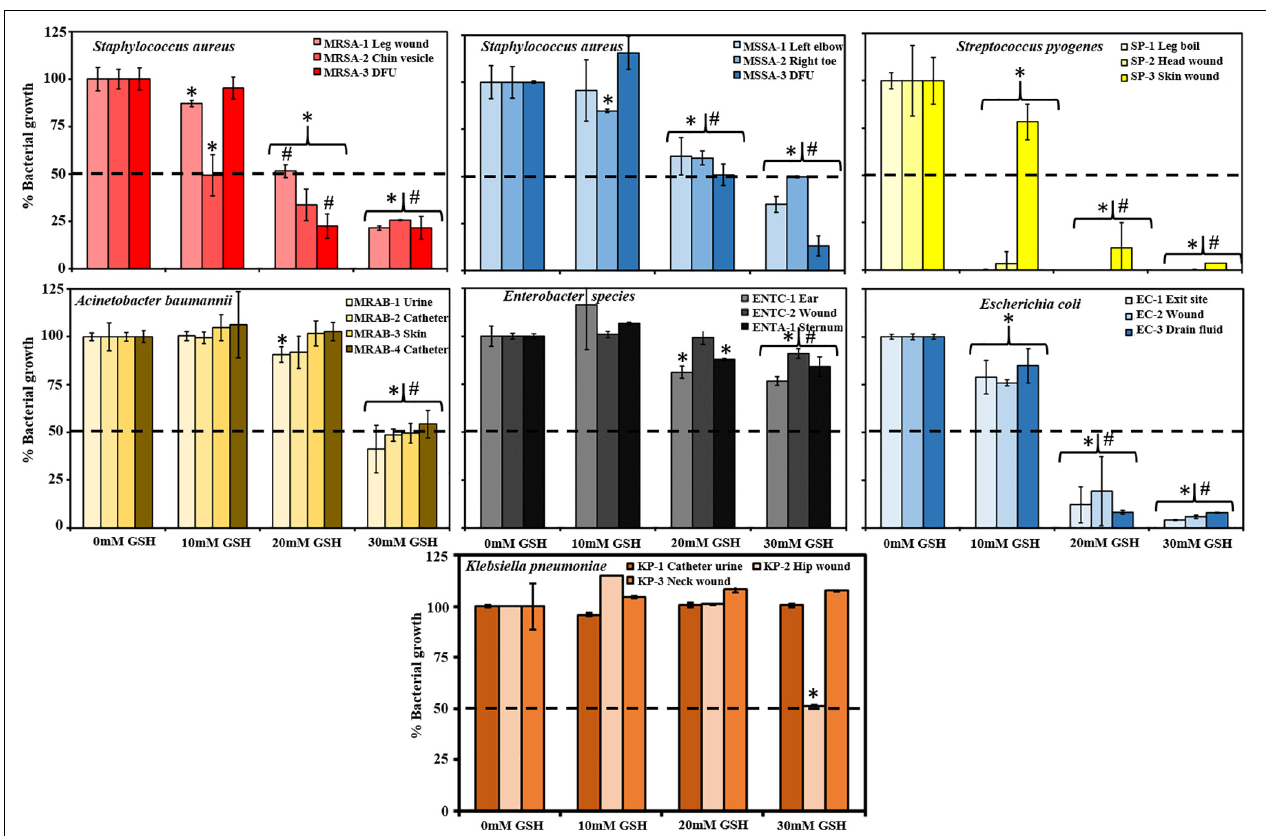
FIGURE 1 | Effect of Glutathione (GSH) on growth of bacterial species isolated from Sydney hospitals. GSH showed concentration-dependent effects in inhibiting bacterial growth. 10 mM GSH did not affect bacterial growth for most of the isolates whereas; 20 mM GSH showed around 50% decrease in bacterial growth for all isolates of Methicillin-resistant Staphylococcus aureus (MRSA) and Methicillin-sensitive S. aureus (MSSA) and a less then 25% decrease for one S. pyogenes and E. coli . 30 mM GSH is very effective inhibiting greater than 50% growth with almost complete inhibition in case of S. pyogenes and E. coli and resistance in case of Enterobacter species and K. pneumoniae . Data represent mean ± SD; n = 4 experiments performed in biological replicates. Dotted line (- - -) in each graph indicates 50% bacterial growth. ∗ P < 0.05 (statistically significant) when compared to control, # P < 0.05 (statistically significant) when compared to 10 mM GSH.